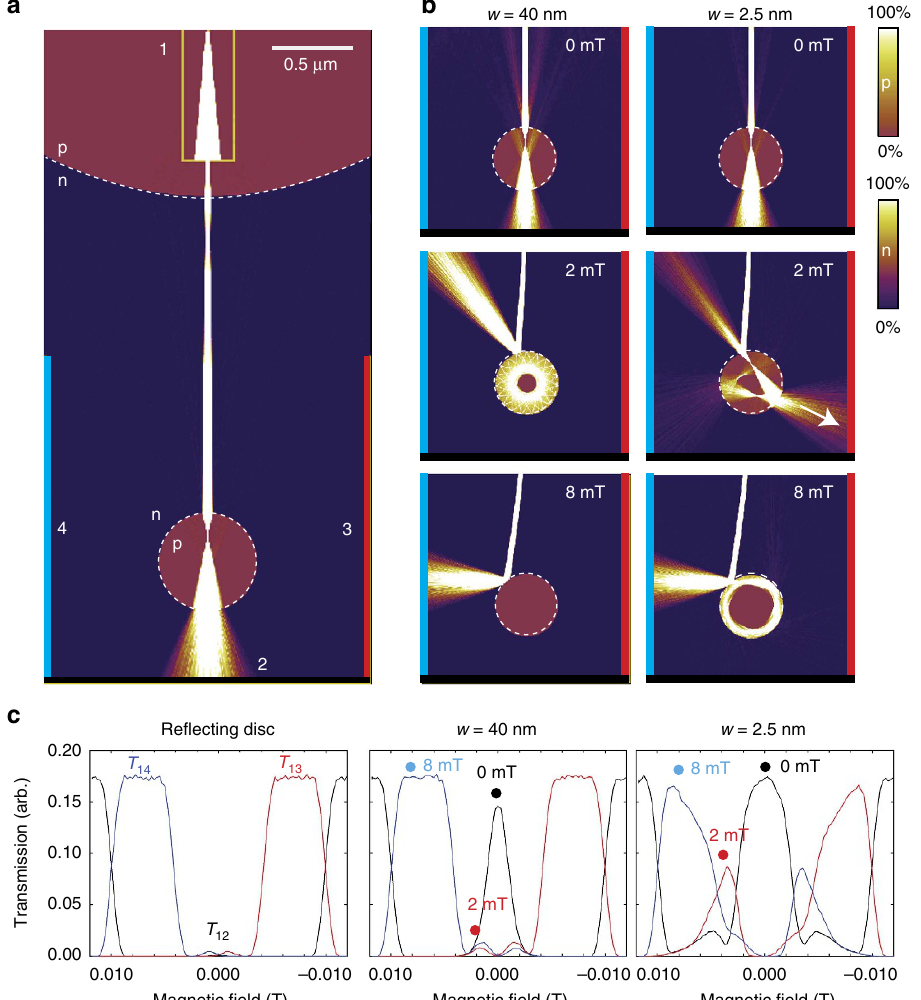
Figure 4 | Imaging of VDs. ( a ) Focused electron beam directed towards a circular p–n junction, a so-called VD, using the DFM configuration in Fig. 3c. The transmission into the VD depends on the angle of the incoming beam with respect to the junction wall. At zero incidence angle (along the centre line), the beam is nearly fully transmitted through the dot, before hitting the back electrode (2, black). ( b ) shows the current density for two different p–n junction width, w ¼ 2.5nm (close to hard-wall limit) and w ¼ 40nm. Hexagonal boron nitride layers thickness is typically in the range 10–100nm 34,47 . Colour scales ranging from 0% (zero current density) to 100% (high current density) are used to visualize zones (p,n) with different carrier polarity. ( c ) The calculated transmission coefficients, T 12 (black curve), T 13 (red curve) and T 14 (blue curve), for the three drain electrodes as a function of magnetic field, plotted for two VD with w ¼ 40nm and w ¼ 2.5nm, as well as a reflecting disc. The magnetic field values of 0, 2mTand 8mTare marked as black, red and blue dots. At 2mT, the current jet emitted towards electrode 3 for the w ¼ 2.5nm VD is shown as a large peak (red curve) in the transmission image. At w ¼ 40nm the jet is much